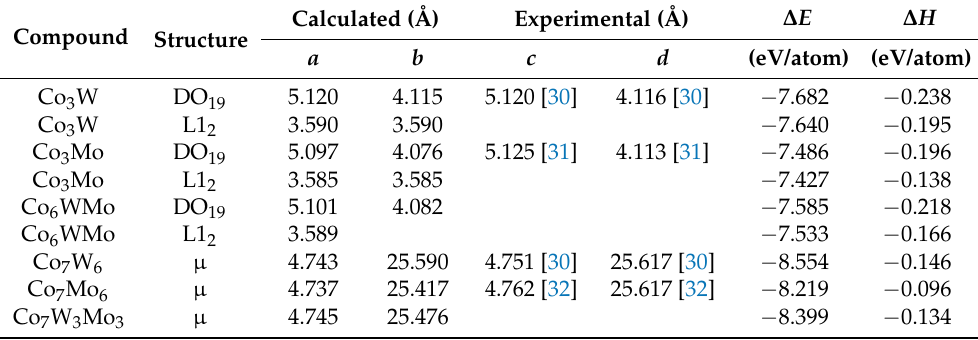
Figure 1. The crystalline structures of ( a ) Co 3 W_DO 19 ; ( b ) Co 3 Mo_DO 19 ; ( c ) Co 6 WMo_DO 19 ; ( d ) Table 1. The calculated equilibrium structural parameters (structure and lattice parameters a and c in Å) compared with the available experimental data [30–32], along with the cohesive ( Δ E) and formation ( Δ H) energies of the Co3X (DO19 and L12) and Co7X6 compounds (in eV per atom).